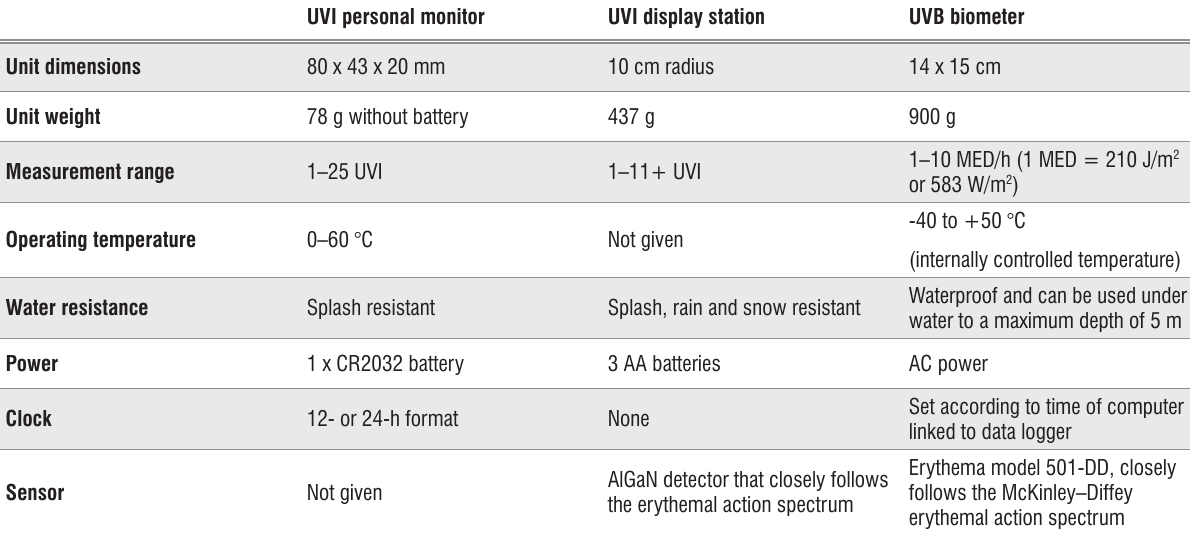
Table 1: Specifications of instruments used in this study for the measurement of solar UV radiation UVI personal monitor UVI display station UVB biometer Unit dimensions